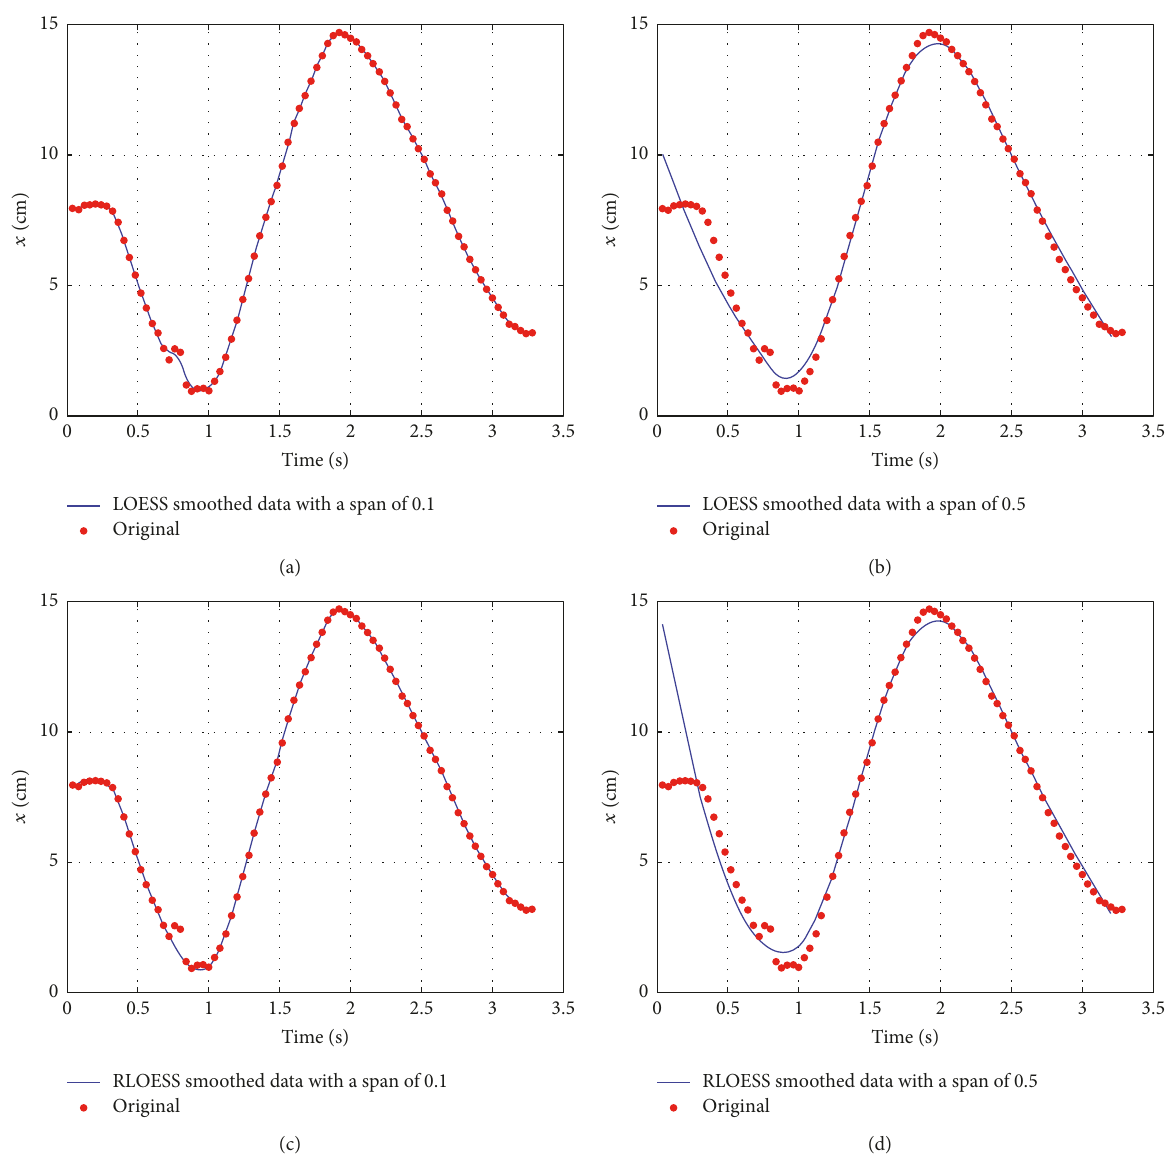
Figure 14: Comparison of original data points (red dots) and smoothed data points (blue curve) using LOESS ((a) and (b)) and RLOESS ((c) and (d)) with different span. (a) span = 0.1; (b) span = 0.5; (c) span = 0.1; (d) span =